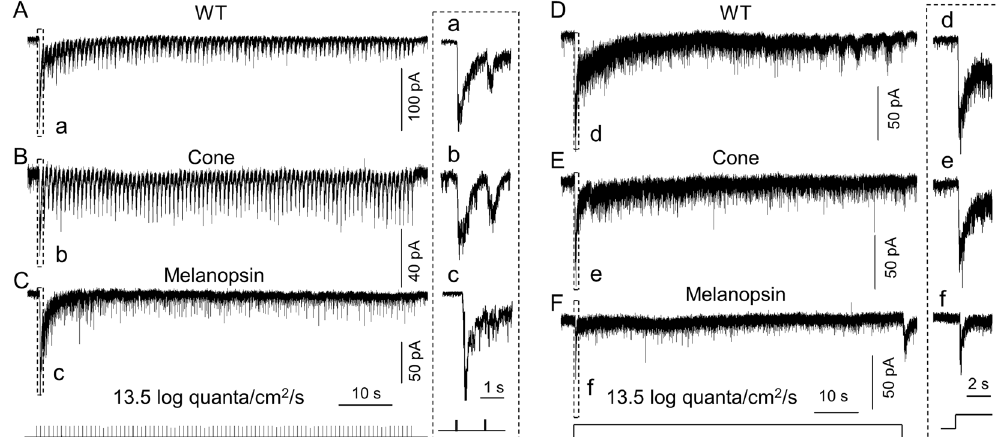
Figure 7. M-cones and melanopsin contribute to DAC responses to bright background light. ( A – C ) An 100 ms-duration, 0.75 Hz flashing light with an intensity of 13.5 log quanta/cm 2 /s was applied to the retina for 2 min. ( A ) Repetitive responses were obtained from a dorsal DAC in a wild-type retina. ( B ) Repetitive responses were obtained from a dorsal DAC in a cone-function-only retina. ( C ) The initial 3 pulses produced a melanopsin- based inward current followed by a steady-state desensitized current. The desensitized current was accompanied by a barrage of miniature EPSC events. Traces in box a , b and c are time-expanded and shown on the right. A series of tick marks at the bottom indicate the pattern of stimuli. ( D – F ) Steady background illumination with an intensity of 13.5 log quanta/cm 2 /s was applied to the retina for 2 min. A WT DAC had an initial inward current in response to steady background illumination ( D ). The current slowly decayed toward the baseline. The cone-mediated DAC response showed a peak current which was slowly desensitized toward the baseline ( E ). A melanopsin-based DAC response showed a peak current which was rapidly desensitized toward the baseline, followed by a steady-state current accompanied by EPSC events ( F ). The peak currents in box (d,e and f) are time-expanded and shown on the right. Stimulation bar shows timing of light